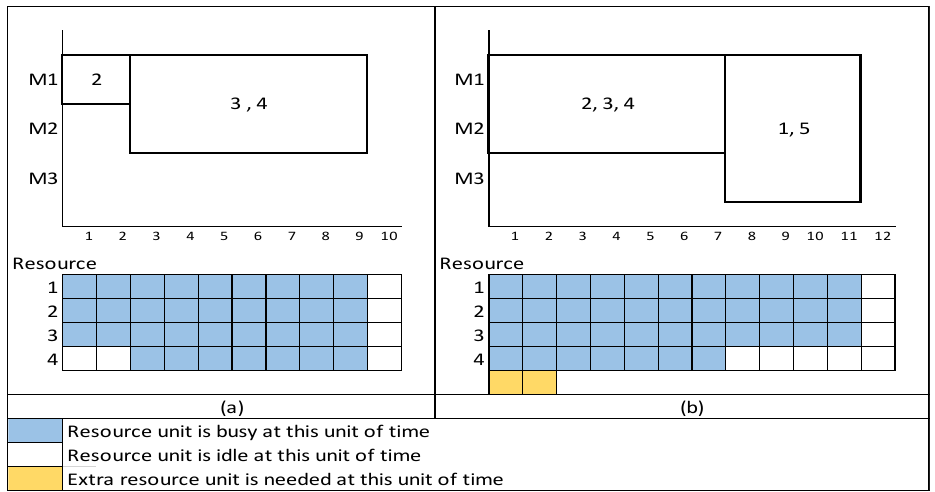
Figure 1. Illustration for the lower bound where M1-M3 are machines: ( a ) first lower bound; ( b ) second lower bound.